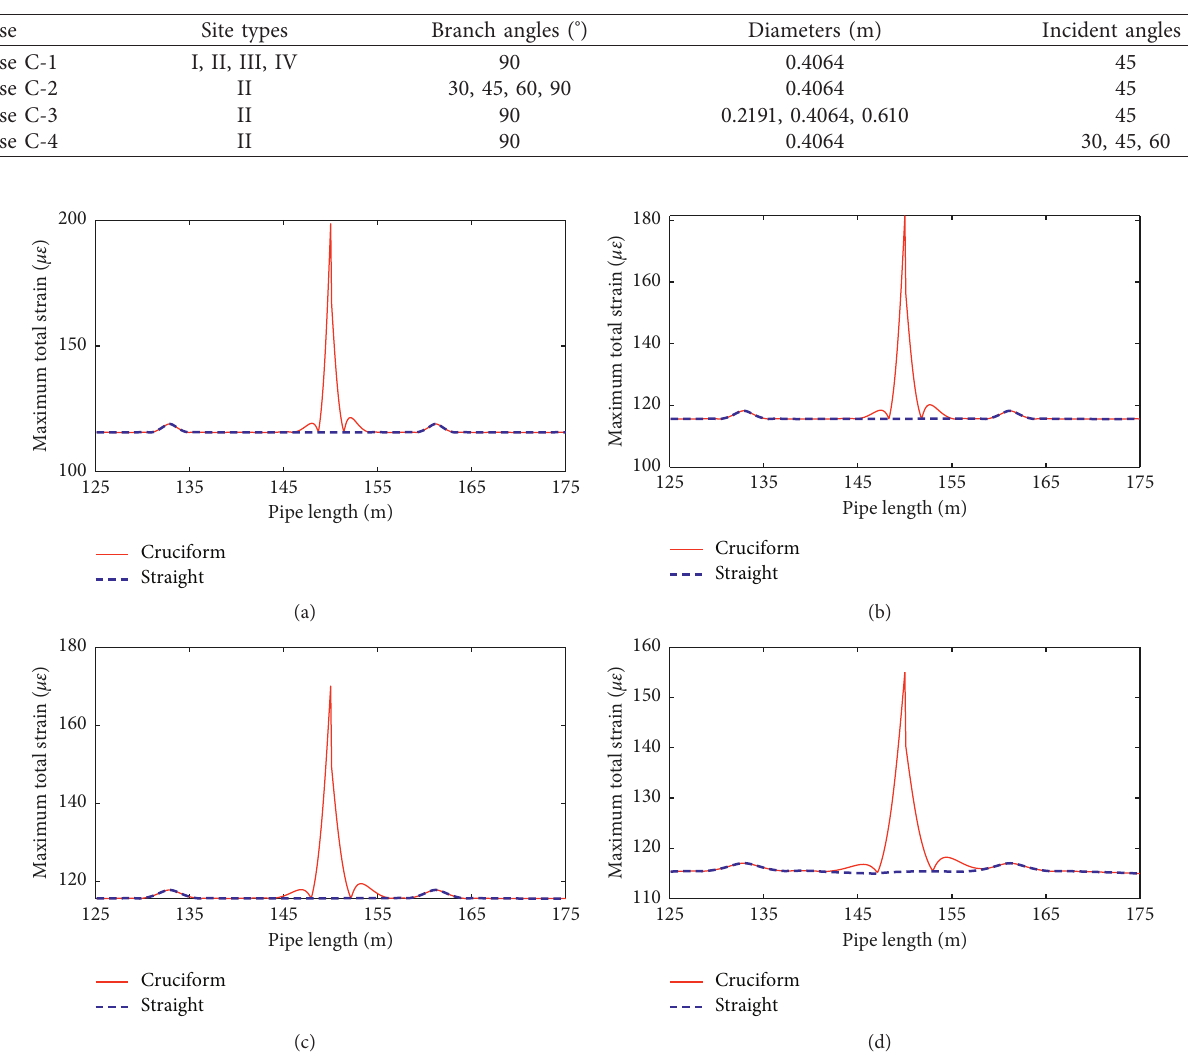
Table 4: Parameters of cruciform connection in different cases.